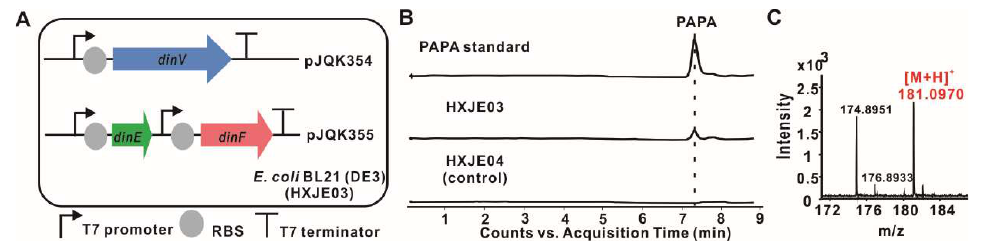
Figure 4. Heterologous expression of PAPA in E. coli BL21 (DE3). ( A ) Schematic representation of PAPA synthesis in engineered E. coli strain HXJE03. Genes dinV , dinE and dinF were all expressed under the control of T7 promoter. ( B ) HPLC-MS analysis of PAPA standard and the products of engineered E. coli strains (HXJE03 and HXJE04). ( C ) HR-ESI-MS analysis result of PAPA.